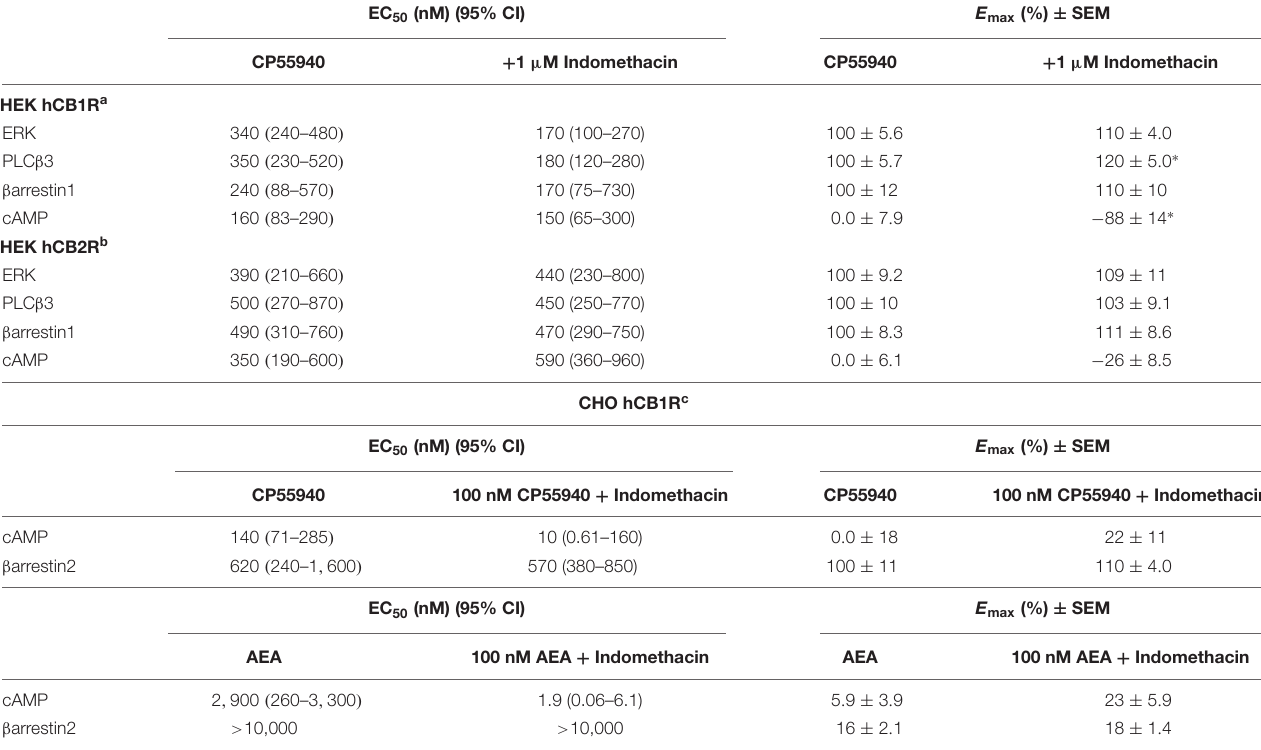
TABLE 2 | Potency and efficacy of indomethacin at modulating agonist-dependent